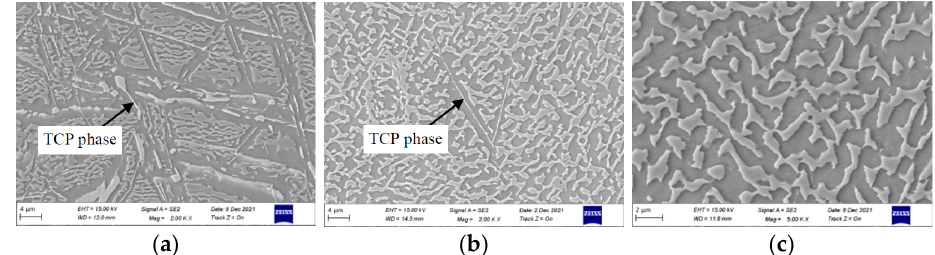
Figure 10. Microstructure adjacent to the fracture surface of the ruptured samples at 1100 °C/137 MPa (353.6 h): ( a ) 6% Co; ( b ) 9% Co and ( c ) 12% Co.